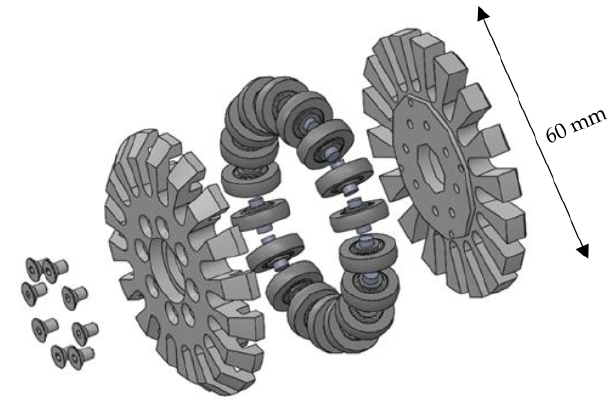
Figure 3. The 3D CAD design of the omnidirectional wheel.